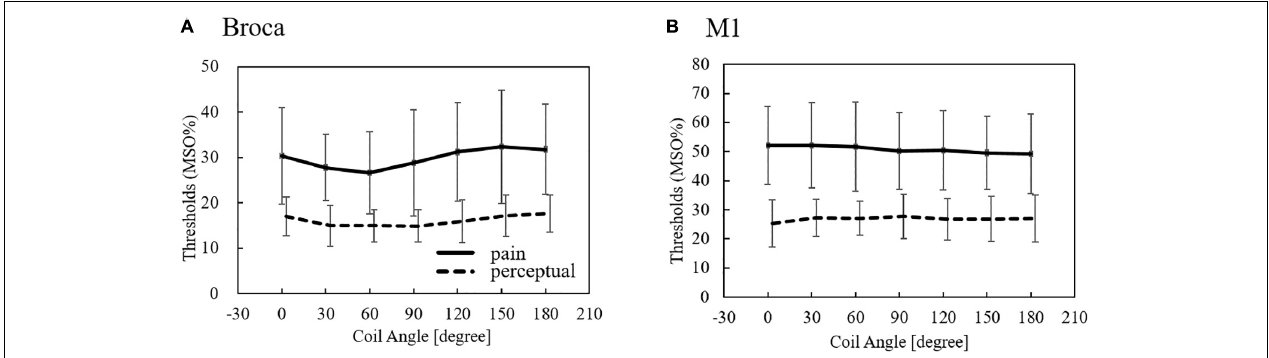
FIGURE 3 | Measured perception and pain thresholds over Broca’s and M1 areas (average ± SD, n = 12). The thresholds are given by the MSO% of the device. SD: standard deviation.